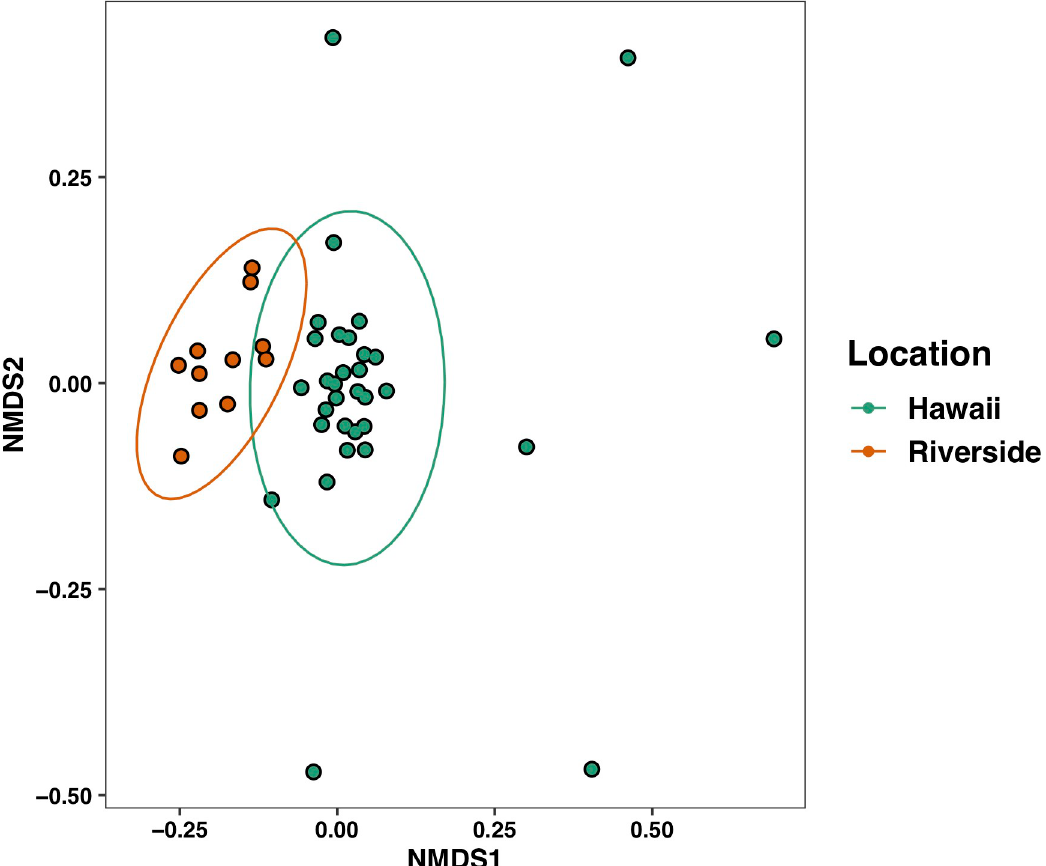
Fig 4. Non-metric multidimensional scaling (NMDS) plot of the Bray-Curtis dissimilarities of samples between Riverside and Hawaiian locations. Sampling location significantly affected the wasp microbiome (F = 5.9, R 2 = 0.12, P < 0.001).